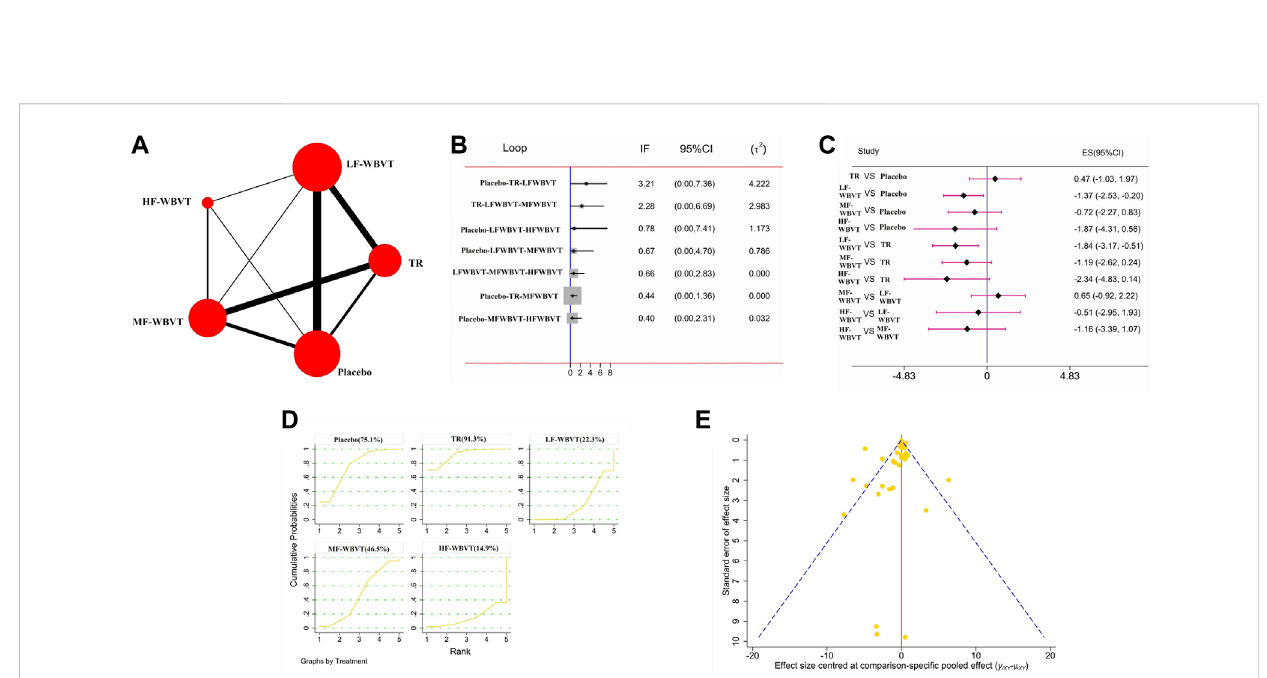
FIGURE 3 Network meta-analysis results for TUGT. (A) Network evidence diagram; (B) loop inconsistency test; (C) Forest plot; (D) The fi gure of Cumulative probability ranking; (E) funnel